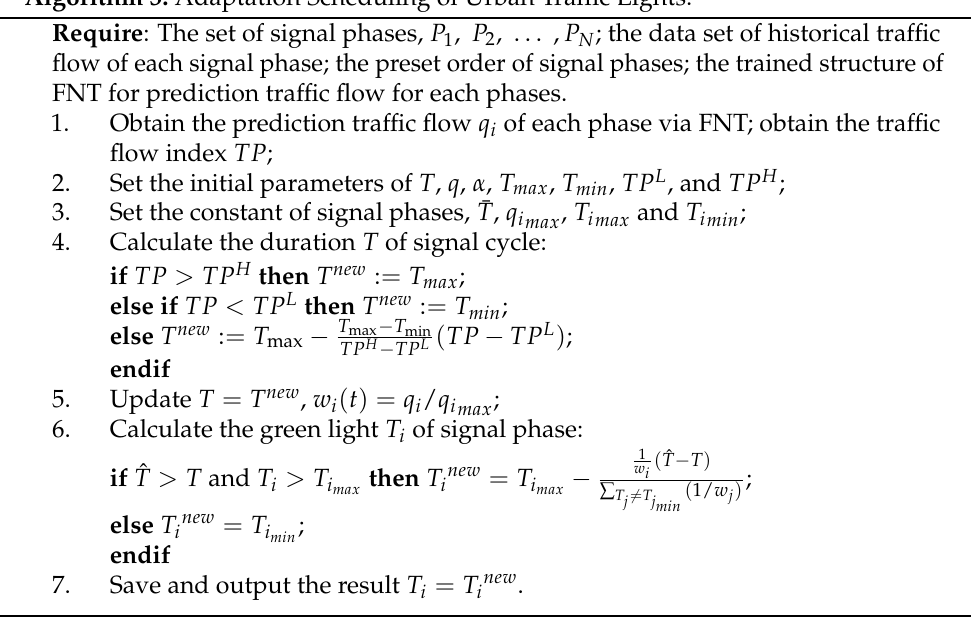
Algorithm 3: Adaptation Scheduling of Urban Traffic